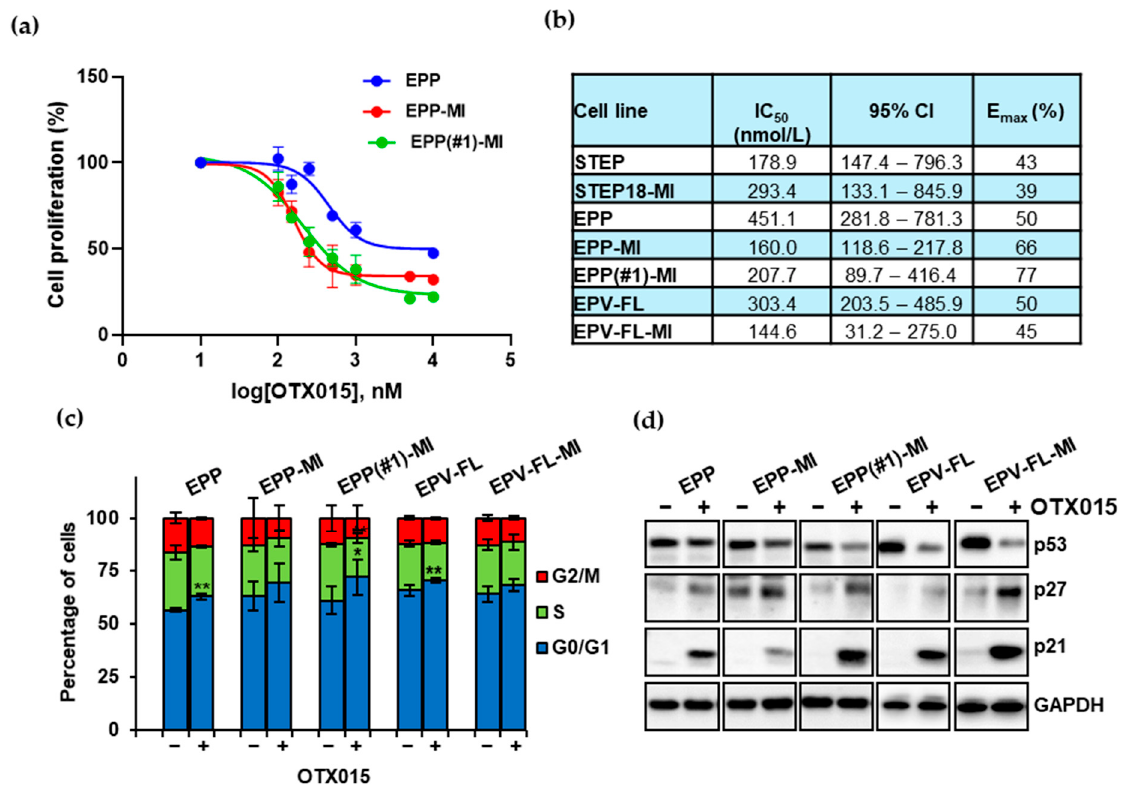
Figure 2. The BETi OTX015 decreases proliferation of EPN cell lines by altering the cell cycle distribution and the expression of regulatory proteins p27 and p21. ( a ) Dose-dependent antiproliferative effects of OTX015 in the indicated lines were determined by cell counting after 72-h exposure. Results represent cell proliferation percentage with respect to vehicle- treated control cells for three independent experiments performed in duplicate (mean ± SD; n = 6). ( b ) IC 50 values with 95% confidence intervals; Emax (%) indicates the maximum inhibitory response induced by OTX015 on cell proliferation. ( c ) Cell cycle progression of the indicated EPN lines was evaluated after 24 h of exposure to 500 nM OTX015. The percentages of the total cell population in the different phases of the cell cycle were assessed by flow cytometry. Each bar represents the mean ± SD from three independent experiments (* p < 0.05; ** p < 0.01; mean ± SD). ( d ) Western blot analysis of total lysates from EPN cells treated with a vehicle or 500 nM OTX015 for three days. Blots were probed with the indicated antibodies. Glyceraldehyde 3-phosphate dehydrogenase (GAPDH) was used as a loading